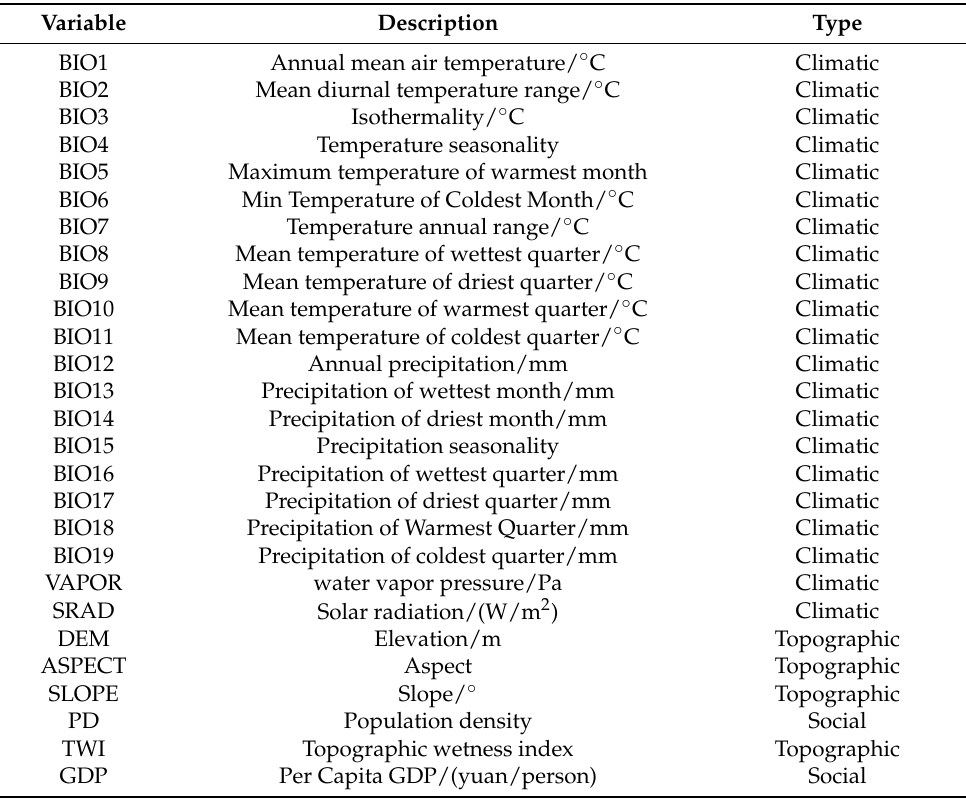
Table 2. Environmental